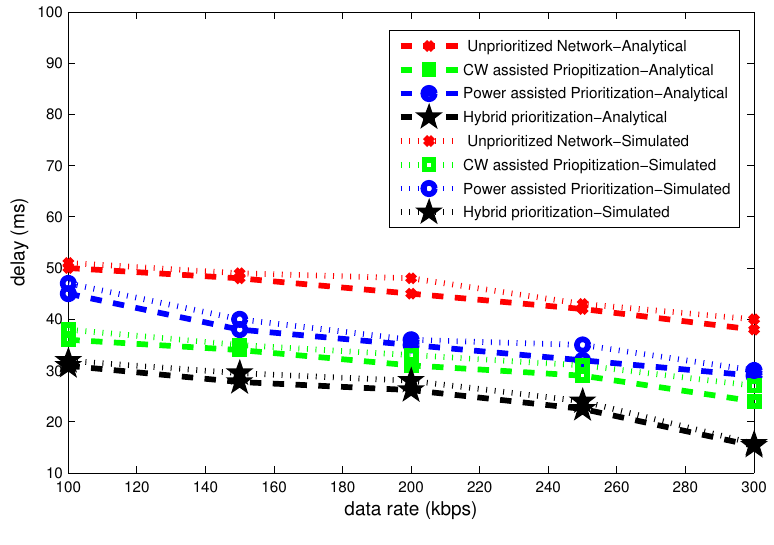
Figure 14. Effect of data rate on